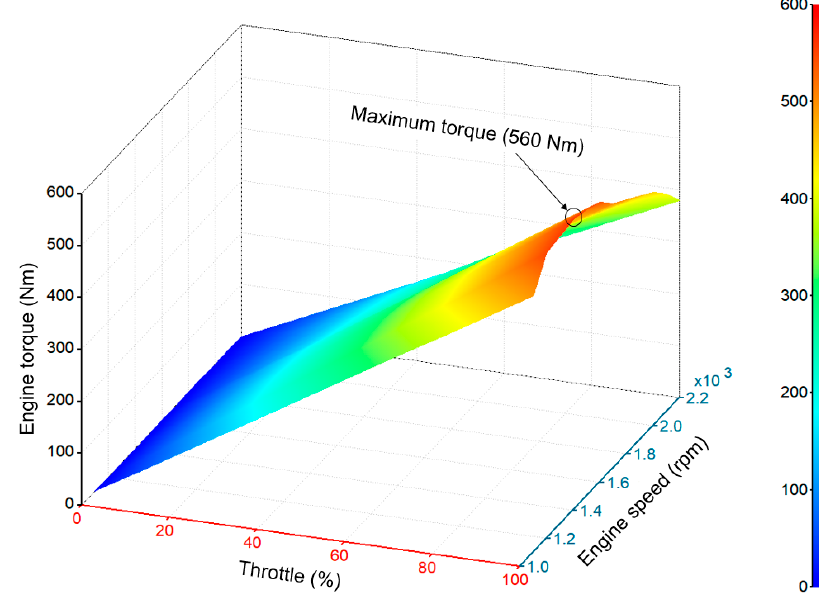
Figure 5. The 95 kW engine characteristics map used in this study.